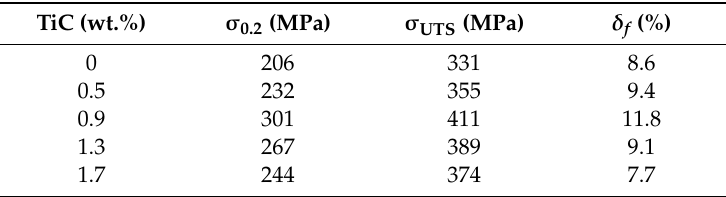
Figure 9. Mechanical properties of the TiC/2219 nanocomposites. Table 1. The tensile data of the 2219 alloy and the TiC/2219 composites with different particle contents at a displacement speed of 2 mm/min.